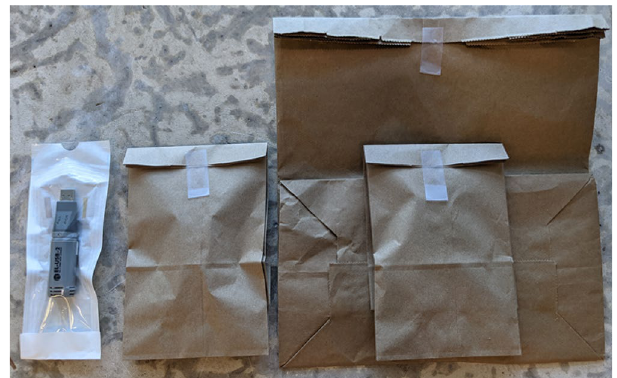
Figure 1. Sealed bags left to right: steam sterilization pouch, single layer paper bag, double layer (grocery and lunch size) paper bags.